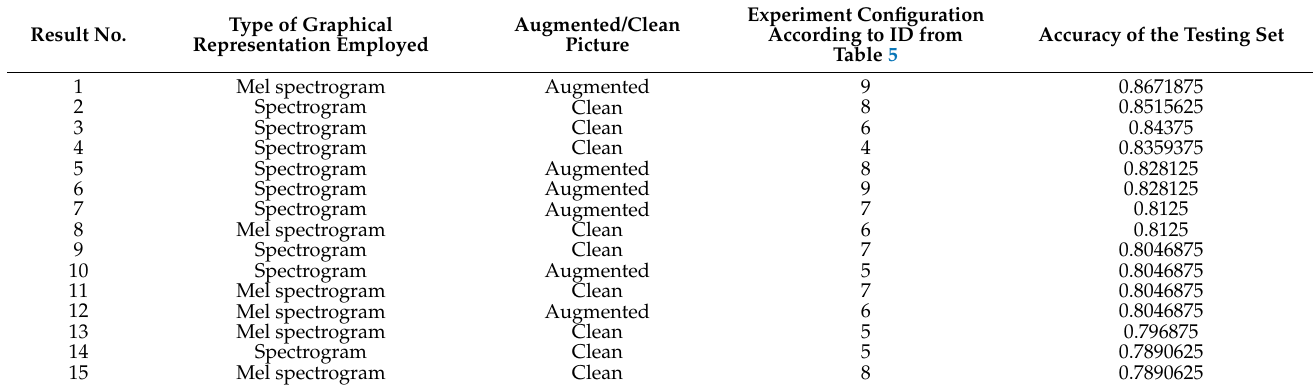
Table 6. A summary of the results of the speech type detection experiments.